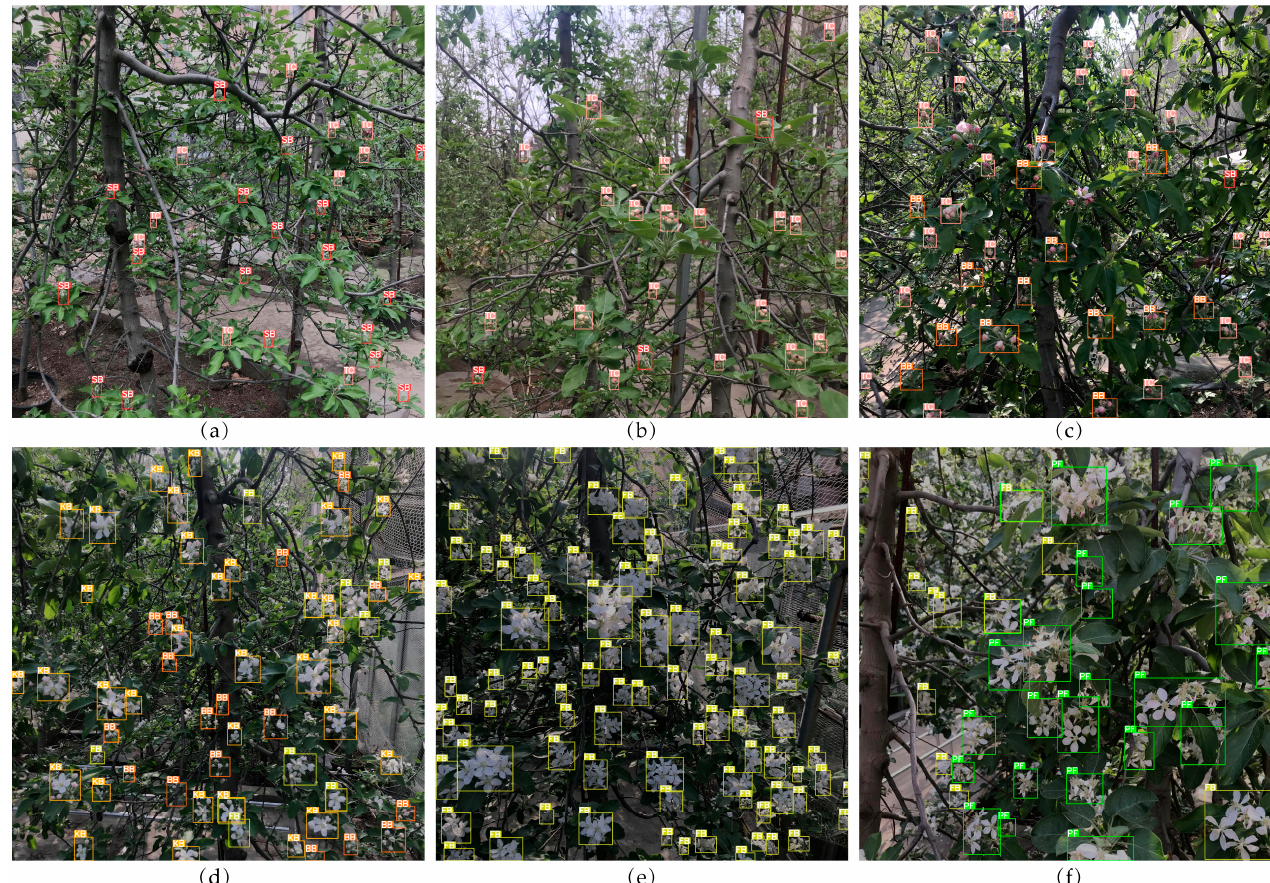
Figure 11. Results of model detection of apple flowers at each blooming level under low light intensity at nightfall. ( a ) Spitting Buds; ( b ) Tight Clusters; ( c ) Balloon Blossom; ( d ) King Bloom; ( e ) Full Bloom; ( f ) Petal Fall.